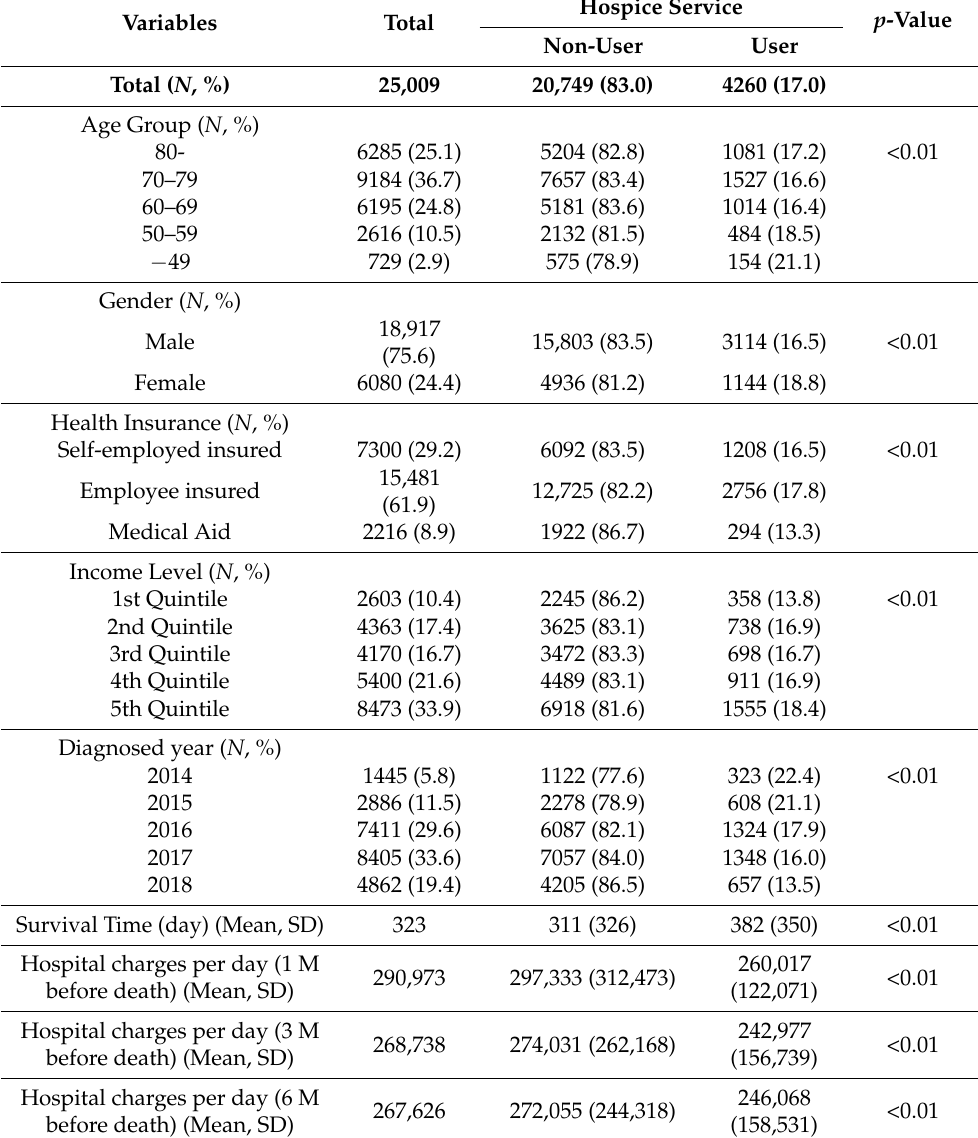
Table 1. General characteristics of study sample by hospice service